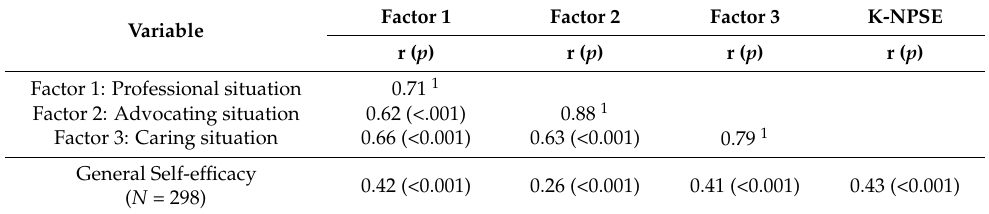
Table 3. Correlation Matrix among Factors of K-NPSE and General Self-efficacy (N =